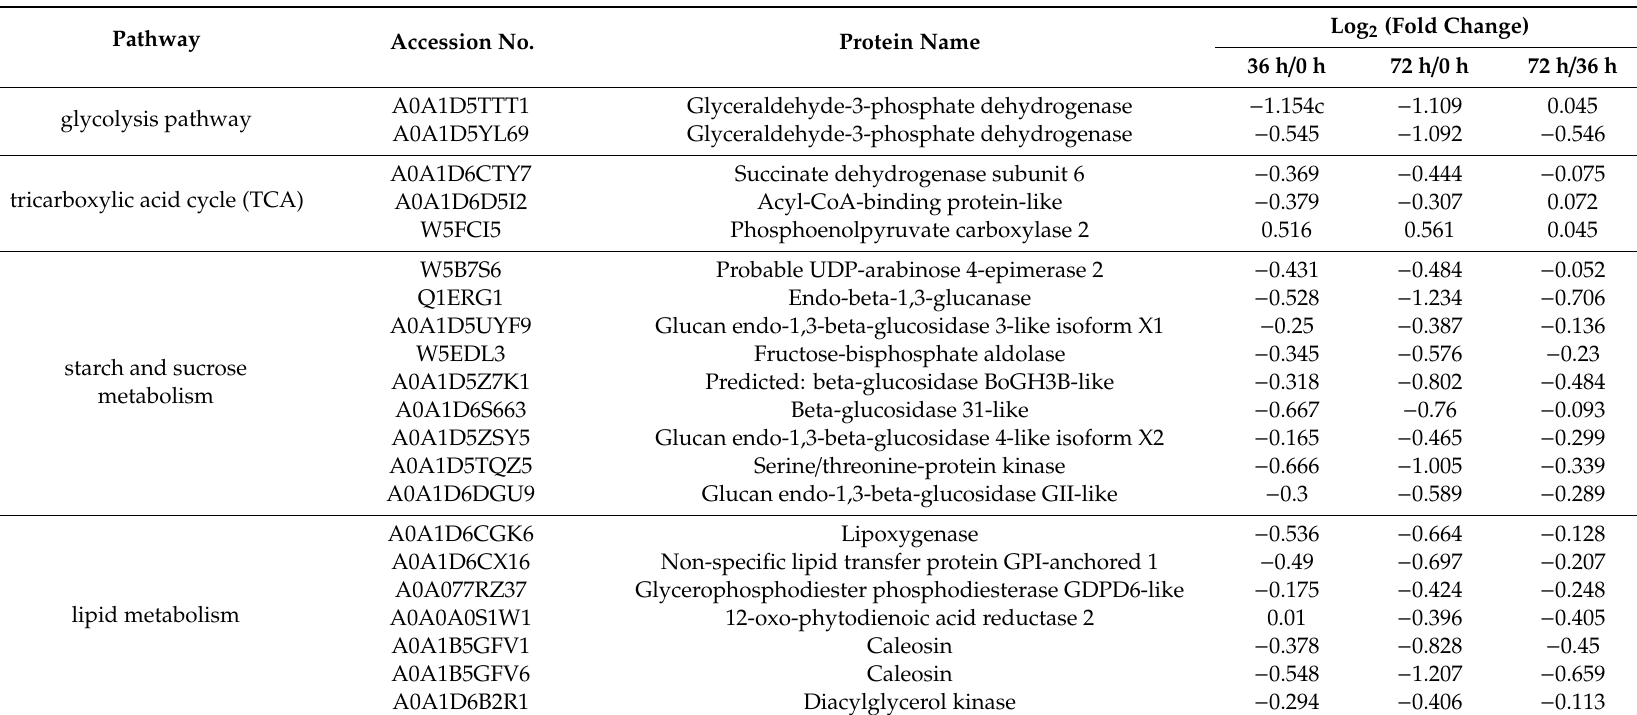
Table 1. Fold changes of DEPs in key pathway in di ff erent